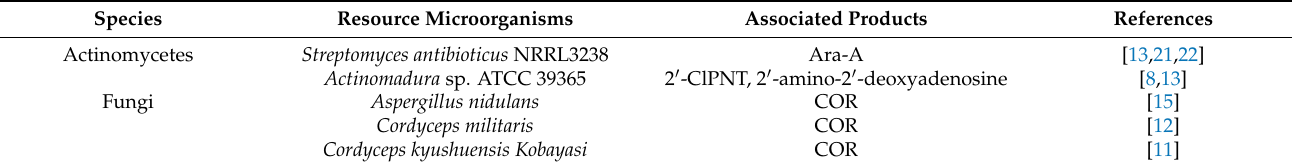
Table 1. The resource microorganisms of PNT and its associated products. Species Resource Microorganisms Associated